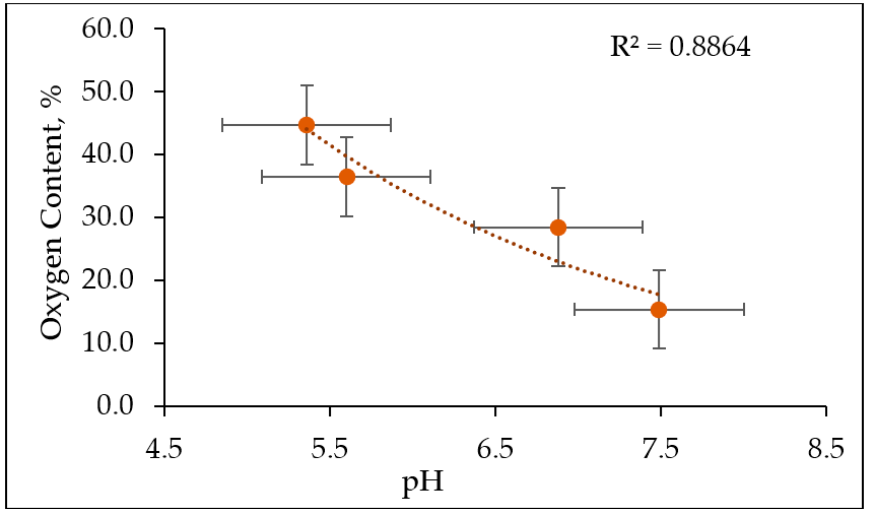
Figure 3. Relationships between pH and oxygen content (%) for sesame stalk feedstock and corre- sponding to biochar produced at 300 °C by parabolic dish collector and conventional method.